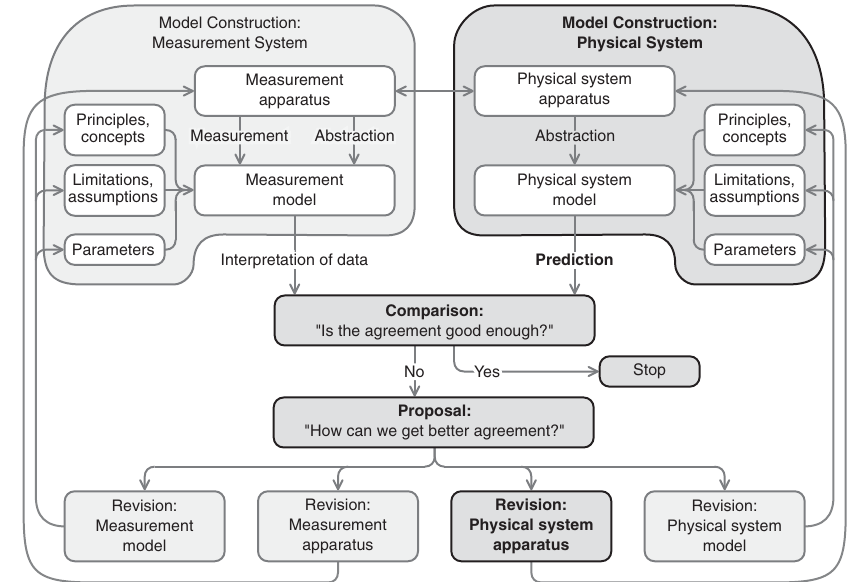
FIG. 2. Modeling Framework for experimental physics. This framework describes the iterative process of constructing models of the measurement and physical systems, comparing measurements to predictions, proposing explanations for discrepancies, and revising models and/or apparatus. Darker shades of gray correspond to phases common in the troubleshooting process. Bold phrases indicate aspects of the framework that informed our a priori analysis scheme. This figure is adapted from the visualization presented by Zwickl et al.